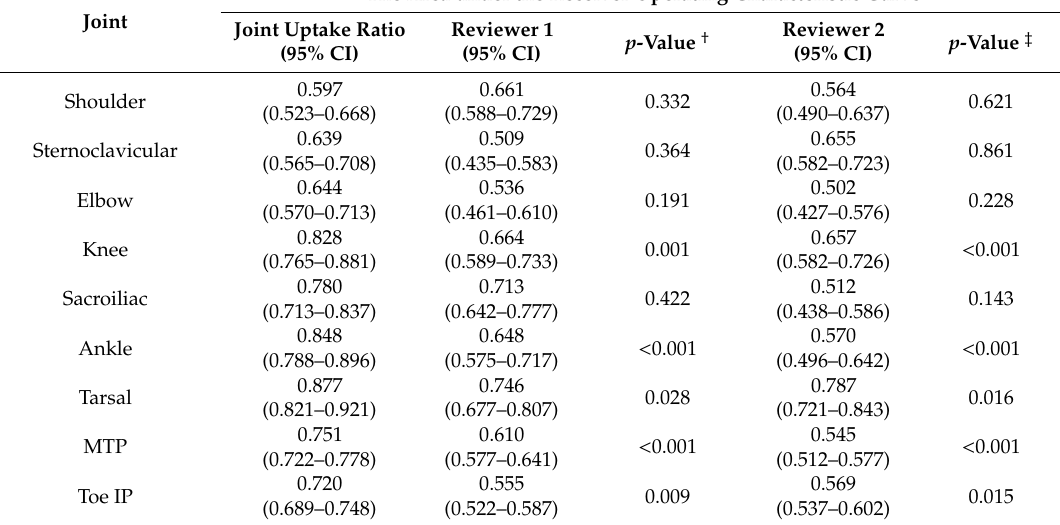
Table 2. Comparisons of the area under the receiver operating characteristic curve values between the joint uptake ratio and the visual analysis results of two readers.